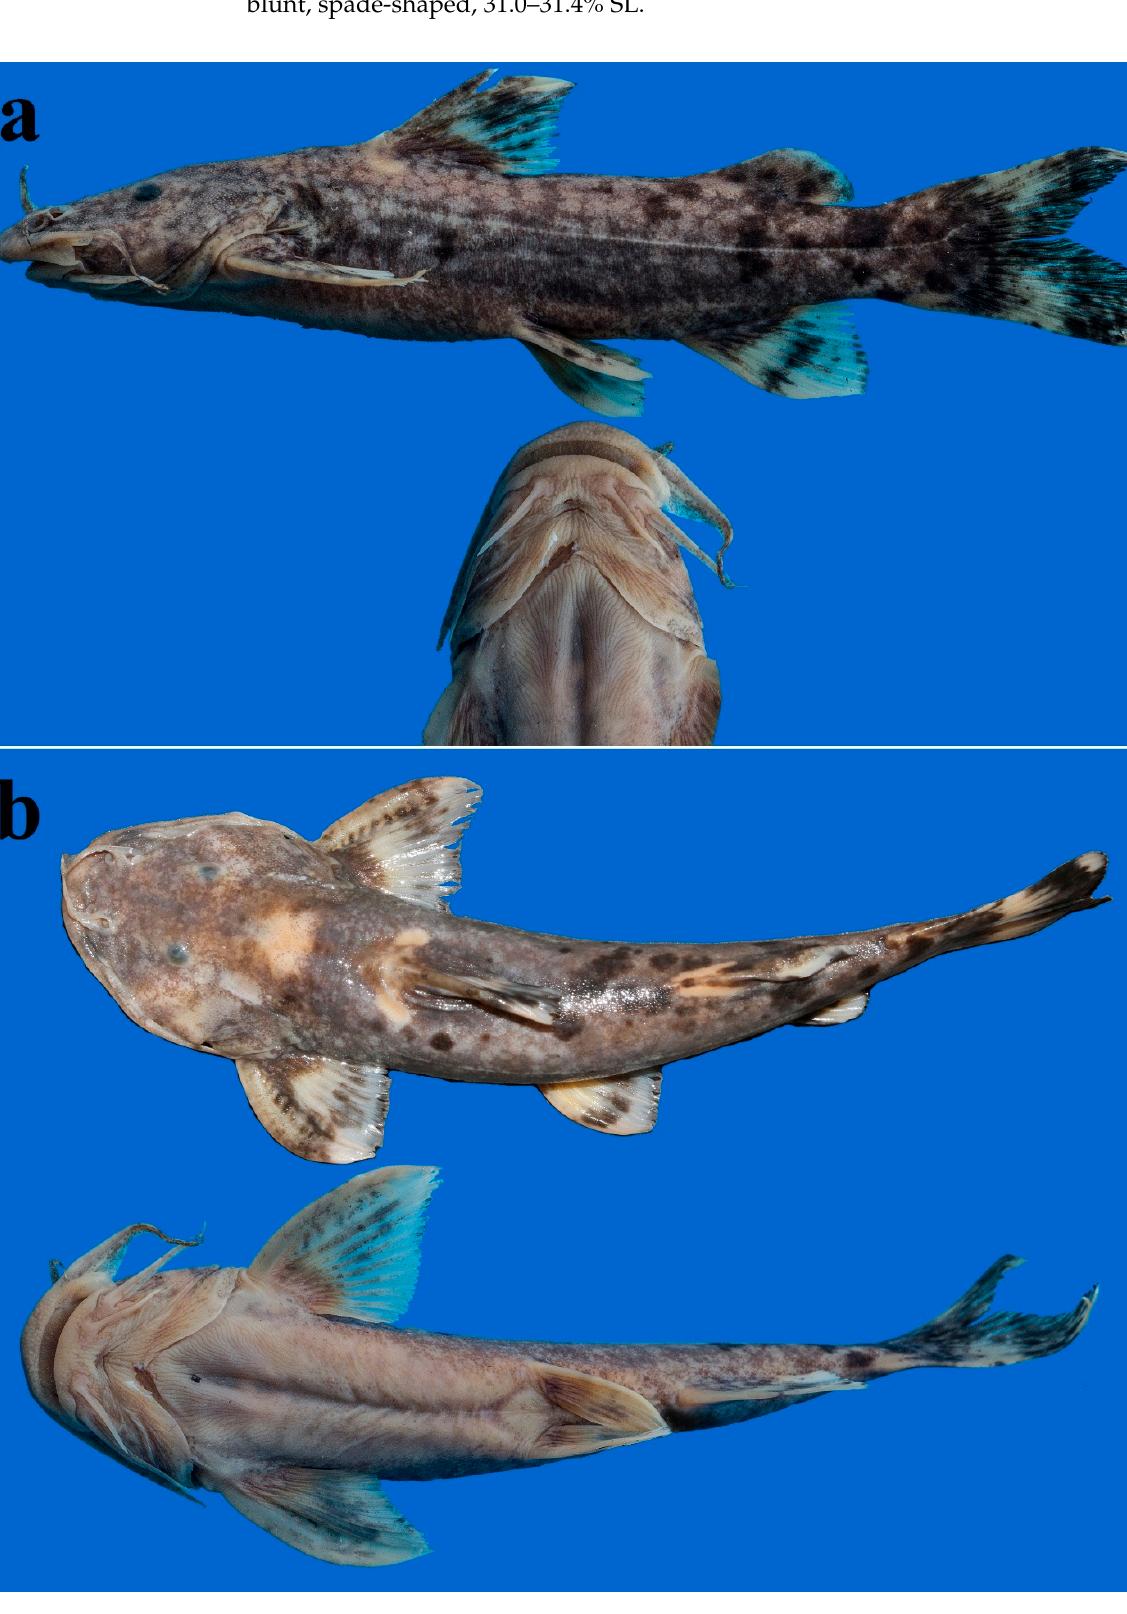
Figure 8. Glyptothorax cous , ( a ) ZM-CBSU H982, 68.4 mm SL; ( b ) ZM-CBSU H974, 98 mm SL; Iran: Seimareh River, Persian Gulf basin.